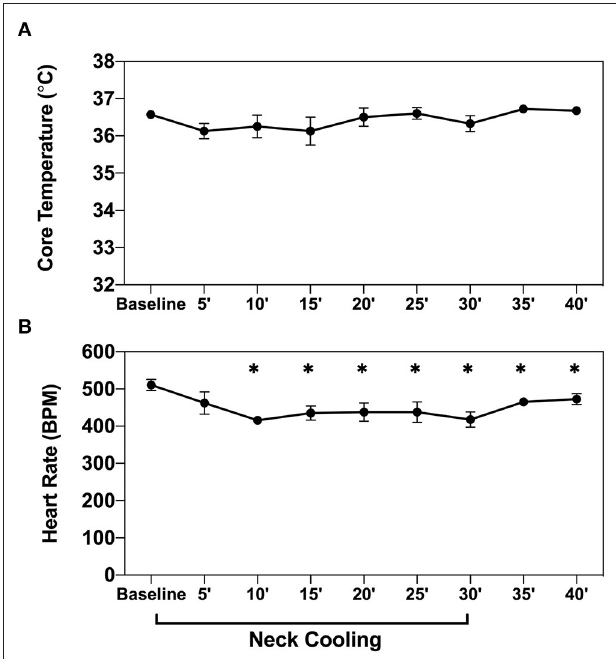
FIGURE 8 | NC slows heart rate without inducing systemic hypothermia. Core body temperature (A) and heart rate (B) were measured in naive wild-type mice ( n = 4) before and then every 5min after application of topical neck cooling for 30min, followed by a 10-min recovery period. NC topical neck cooling;’ min; * p < 0.05 vs. baseline